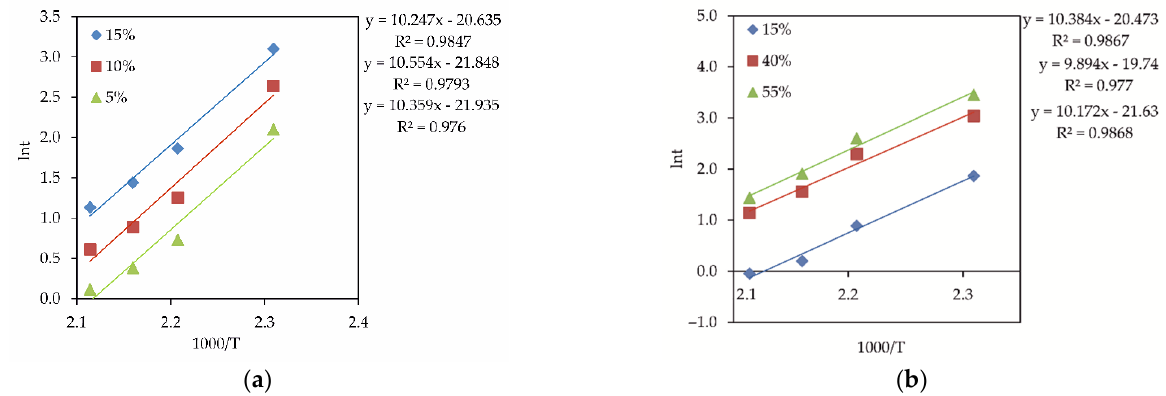
Figure 7. The correlation between Lnt x and 1/T for various As (III) oxidation efficiencies, without ( a ) and with ( b ) Cu (II) The average values of the experimental activation energy of As (III) oxidation are 84.4